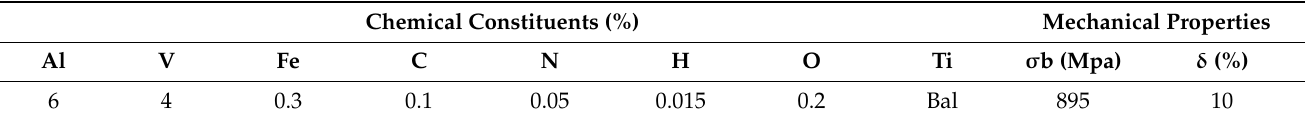
Figure 1. Microstructure of TC4 titanium alloy base metal. Table 1. Main chemical constituents and mechanical properties of Ti-6Al-4V titanium alloy. Chemical Constituents (%).